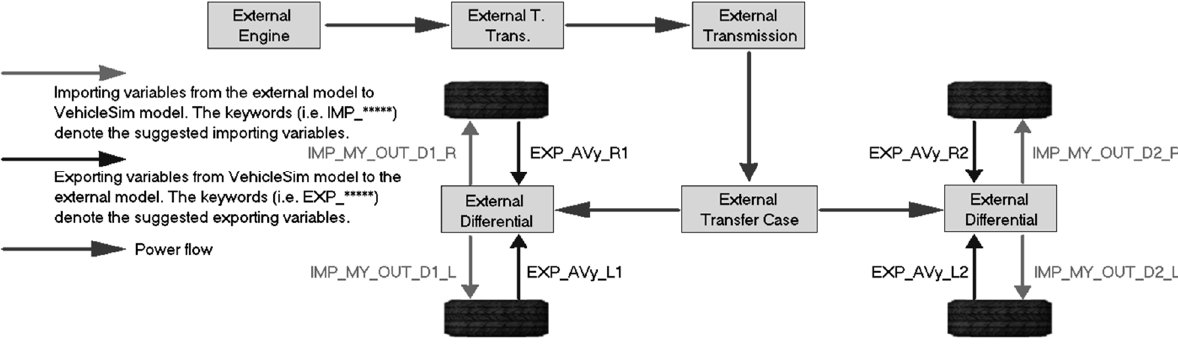
Figure 14. Choose all external powertrain